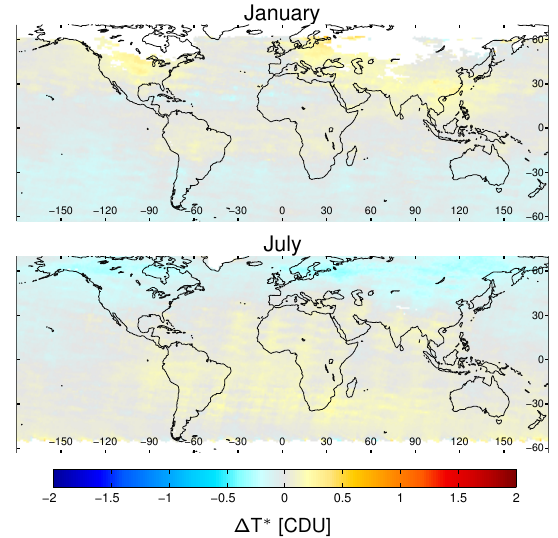
Figure 15. Monthly mean difference of tropospheric residues T ∗ from LNM and STREAM for SCIAMACHY measurements in January (top) and July (bottom) 2010. Gaps at high latitudes in Jan- uary are caused by respective gaps in the FRESCO cloud